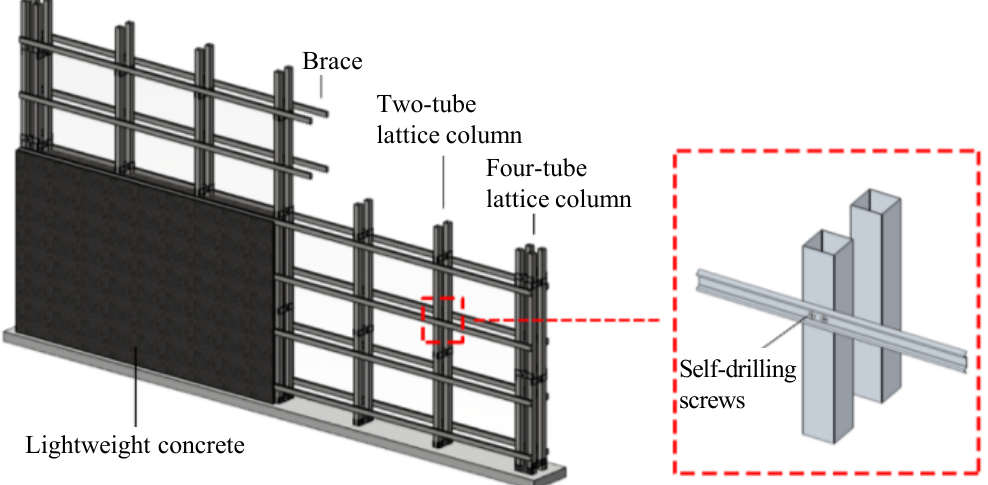
Figure 1. Configuration of the LSLC shear wall.